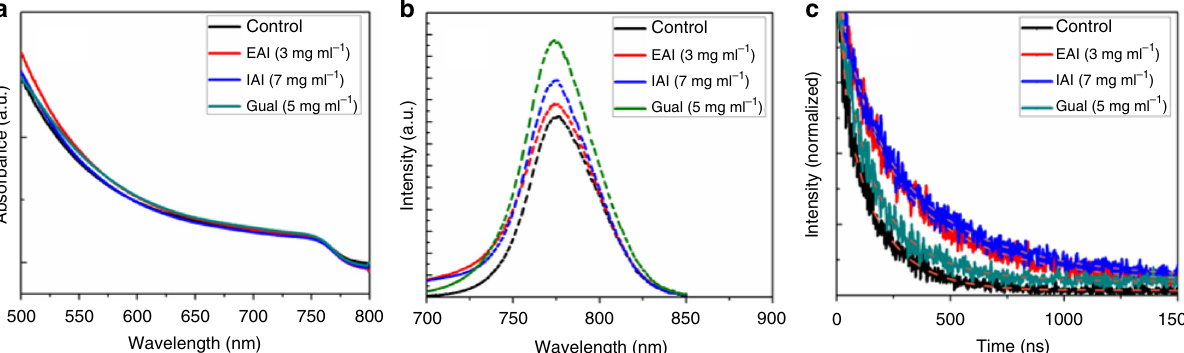
Fig. 4 Optical properties of perovskite fi lms: a Absorbance, b steady-state photoluminescence, and c time-resolved photoluminescence spectra of treated and untreated perovskite fi lms; dashed lines present the fi tting